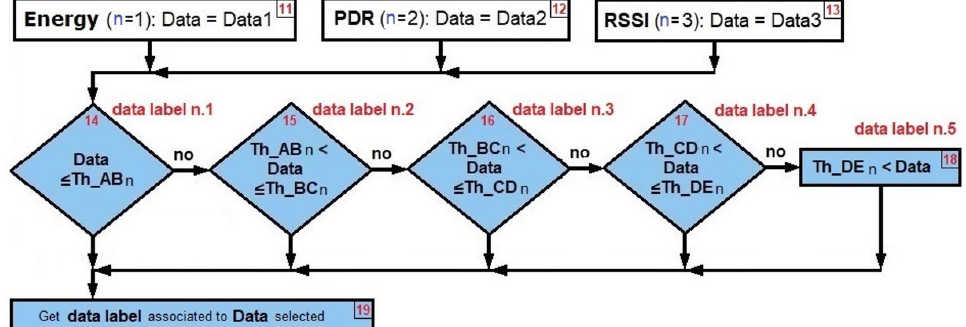
Figure 18. Data threshold decisions.